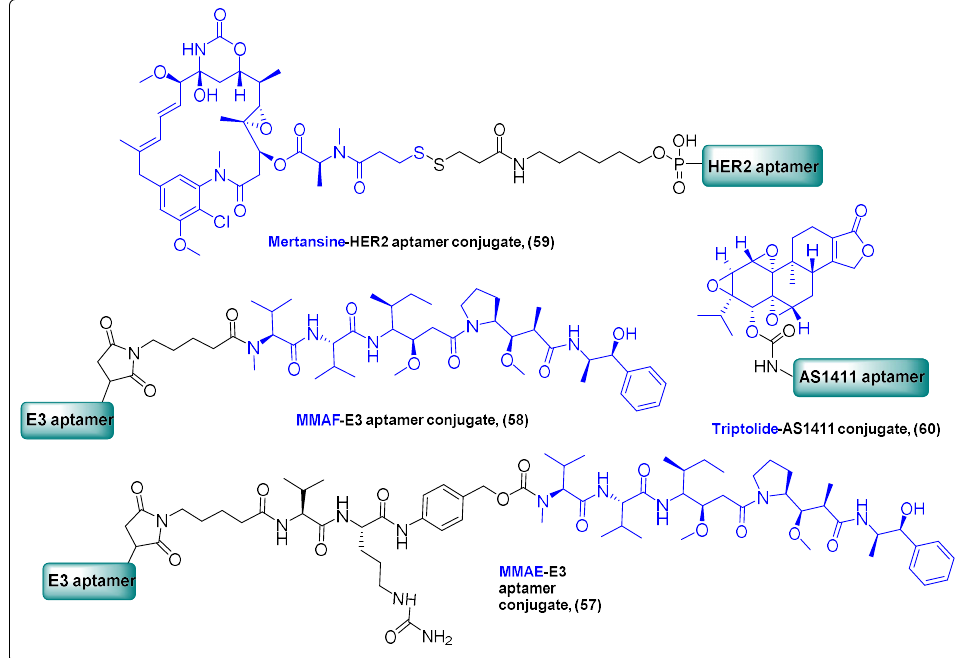
Figure 19. Aptamer–drug conjugates.